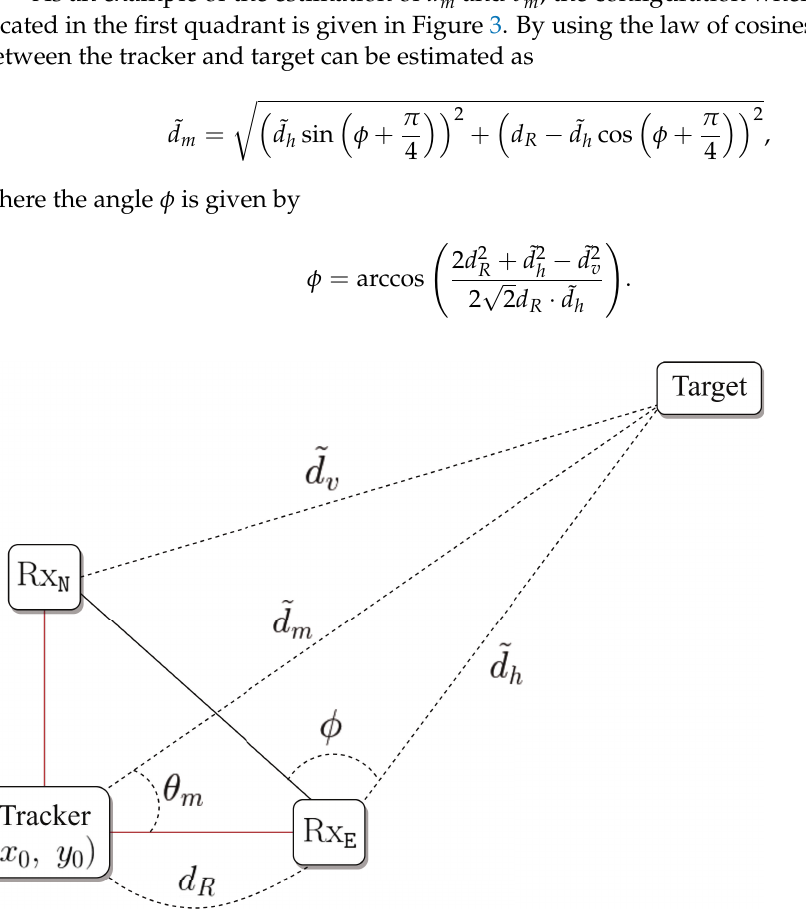
Figure 3. Example in the first